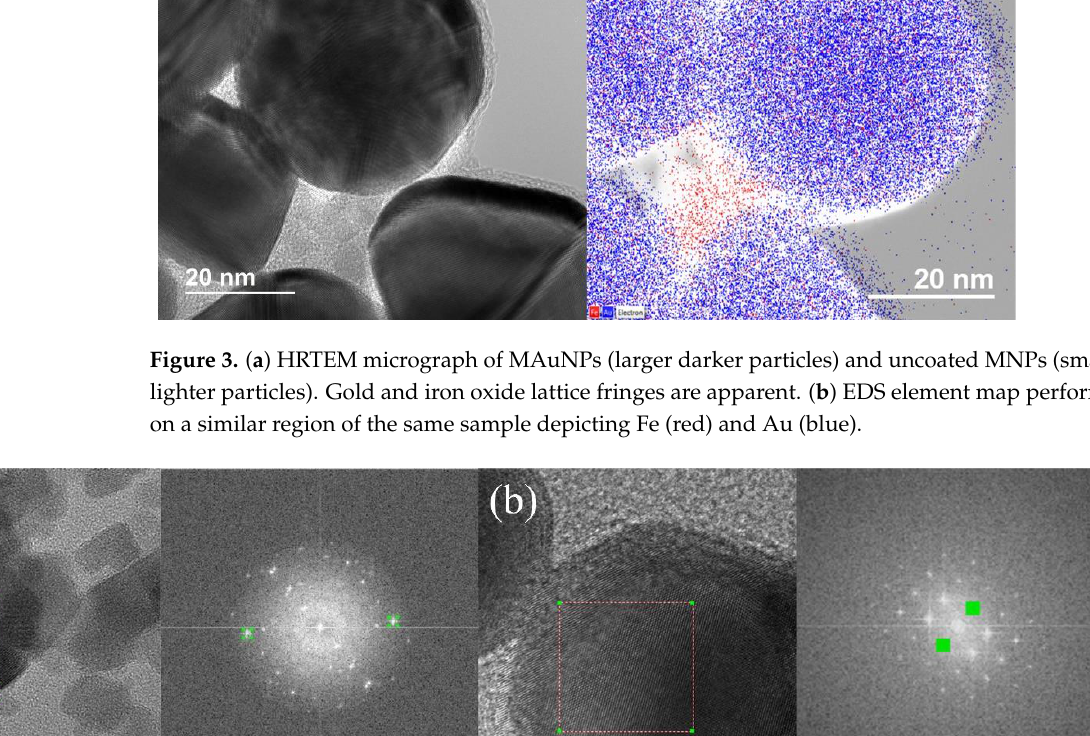
Figure 3. ( a ) HRTEM micrograph of MAuNPs (larger darker particles) and uncoated MNPs (smaller lighter particles). Gold and iron oxide lattice fringes are apparent. ( b ) EDS element map performed on a similar region of the same sample depicting Fe (red) and Au (blue).